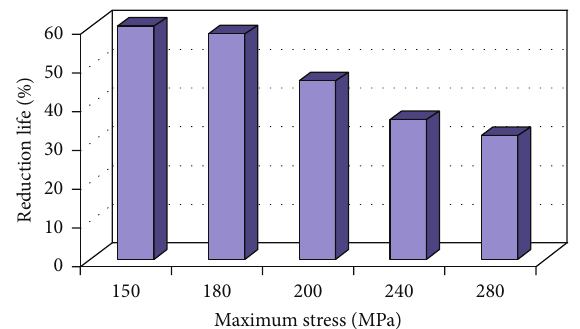
Figure 19: Reduction percentage of fretting fatigue life versus stress